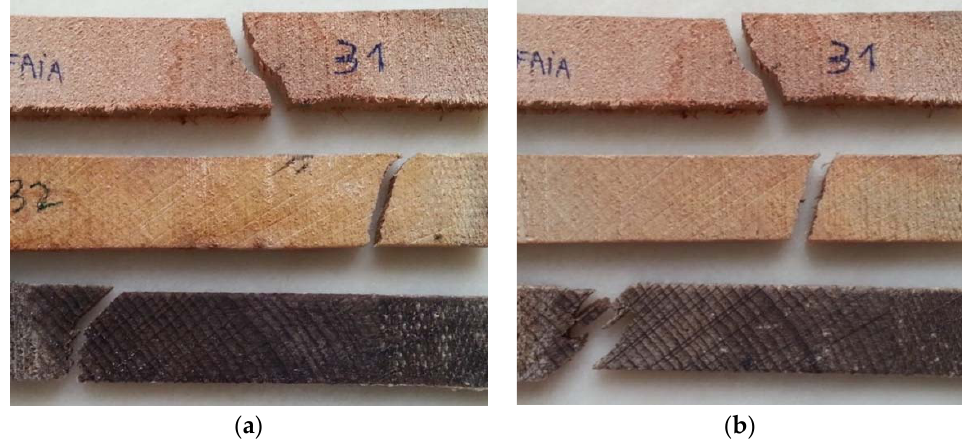
Figure 11. Beech samples submitted to the tensile test after three weeks ( a ) and three months ( b )